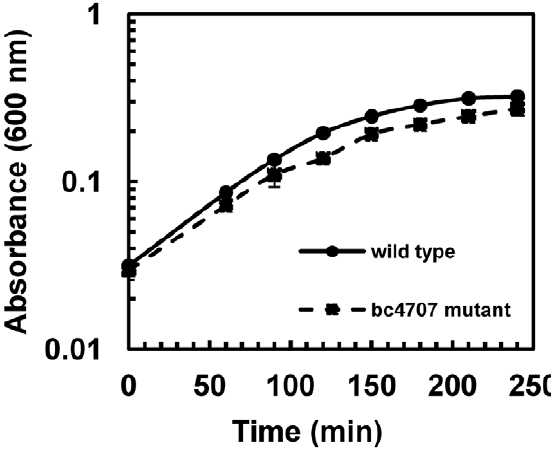
Figure 2. Growth of B.cereus ATCC14579 and D bc4707 mutant under stress with sublethal concentration of norfloxacin. Over night cultures were diluted 1:100 and grown to mid-logarithmic phase. These cultures were diluted to OD 600 of 0.02 in 25 ml LB and norfloxacin was added. The cultures were incubated for 240 min at 30 u C and 220 rpm shaking. The growth curves show averages and standard deviations of two independent experiments.